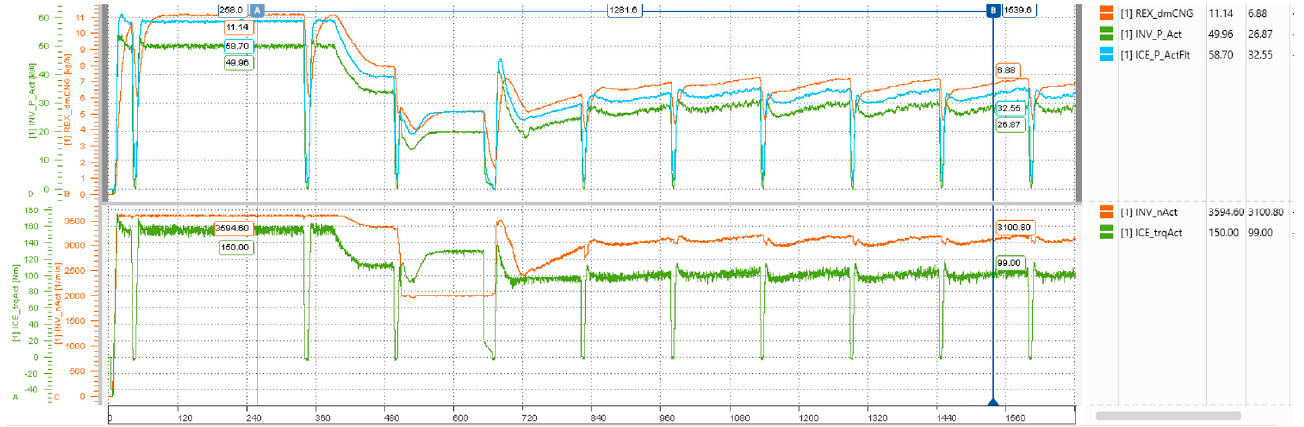
Figure 6. REx operation on a test bench: speed, torque, gas consumption and generated electric power.